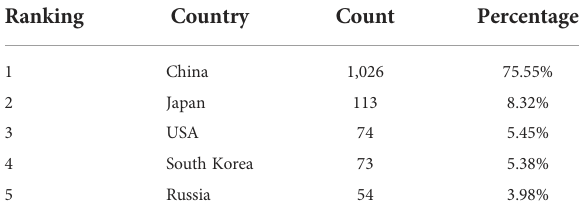
TABLE 2 List of fi ve main source countries of Apostichopus japonicus research papers from 2000 to 2021.